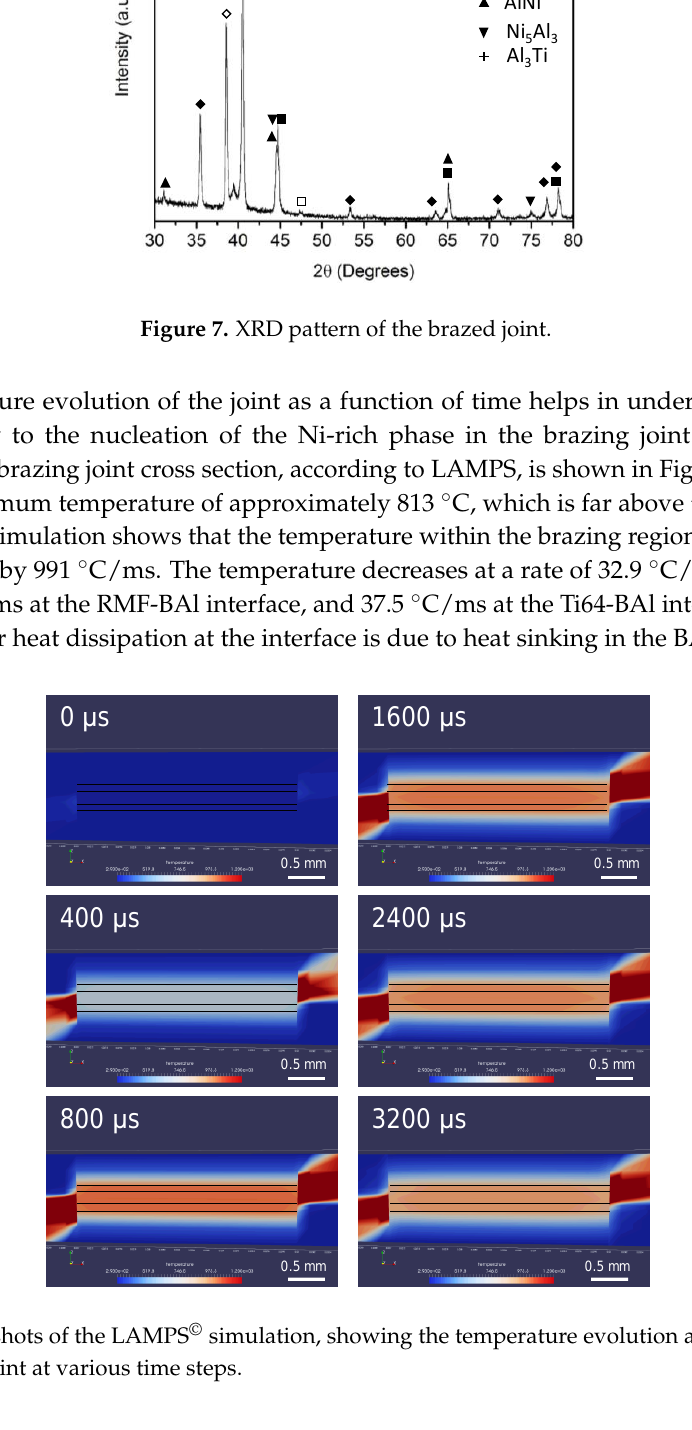
Figure 8. Snapshots of the LAMPS © simulation, showing the temperature evolution and distribution in the brazed joint at various time steps.